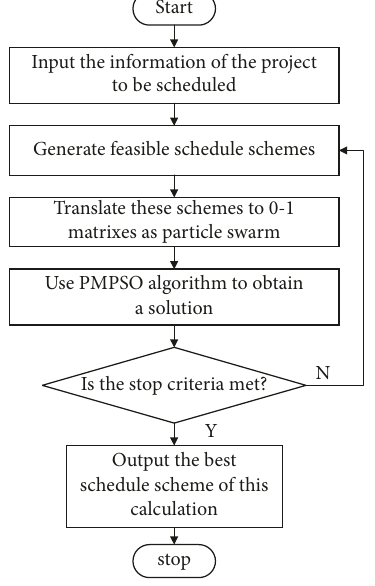
Figure 1: Flow chart of the